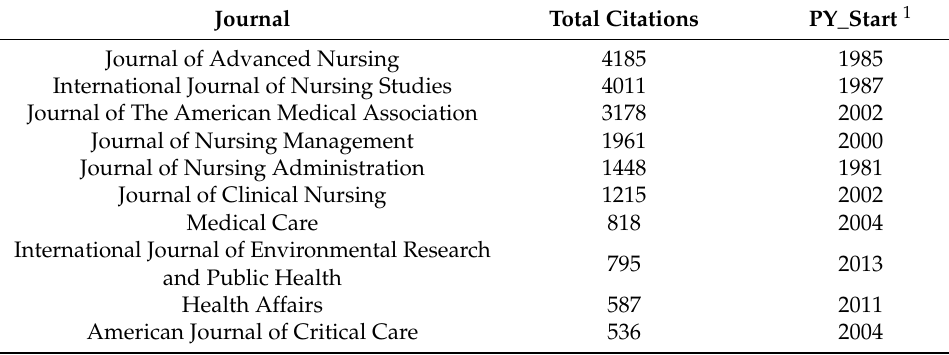
Table 2. Top 10 source impact.